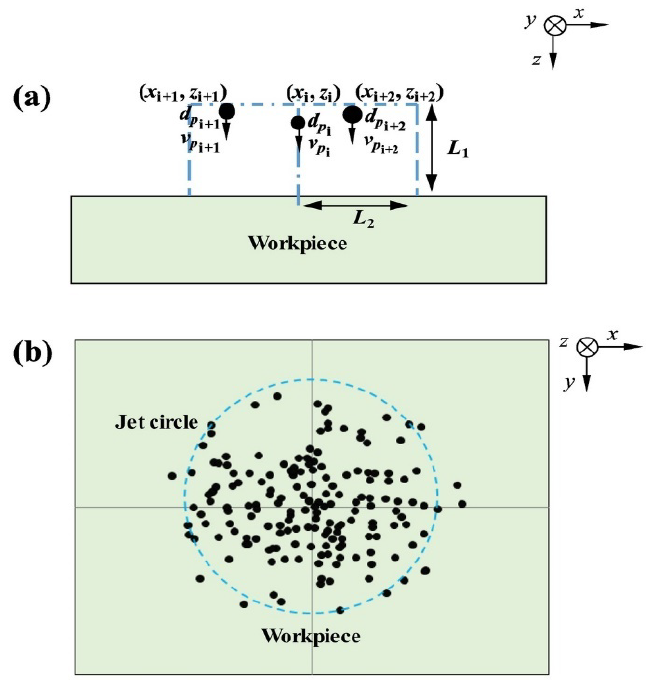
Figure 32. Schematic illustrations of the stochastic abrasive particle flow in the computational model. ( a ) The generation procedure of multiple impacting particles is ( b ) the top view of particle footprints, where the dashed line represents the jet circle [185].